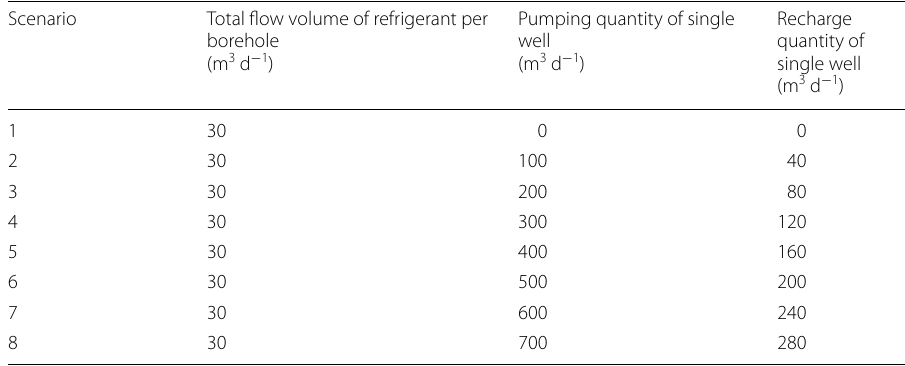
Table 5 Operation scenarios of the coupling pumping–injection wells and the BHEs